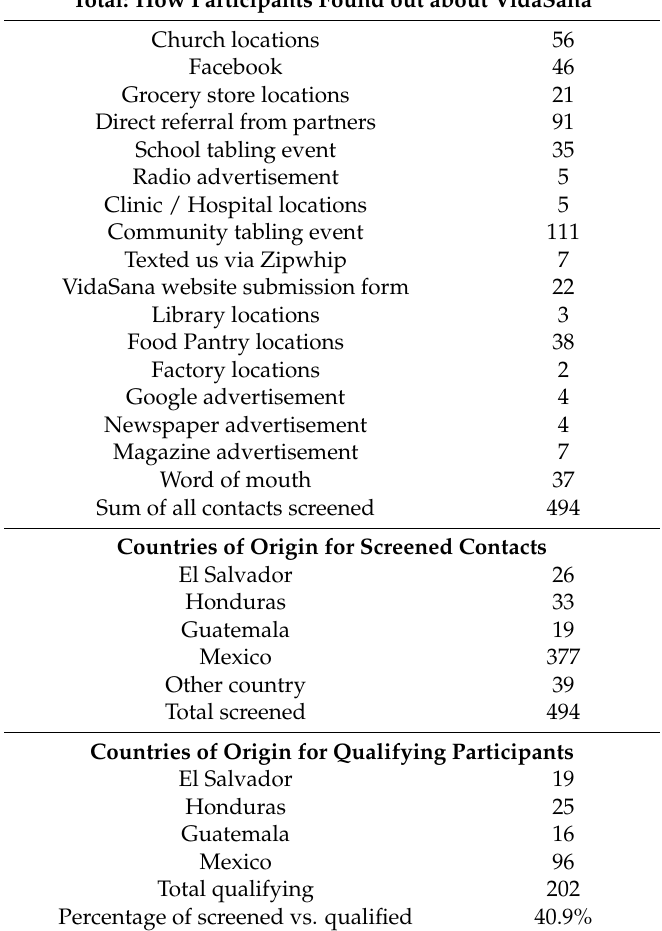
Table 2. Screening and Recruitment August 2017–September